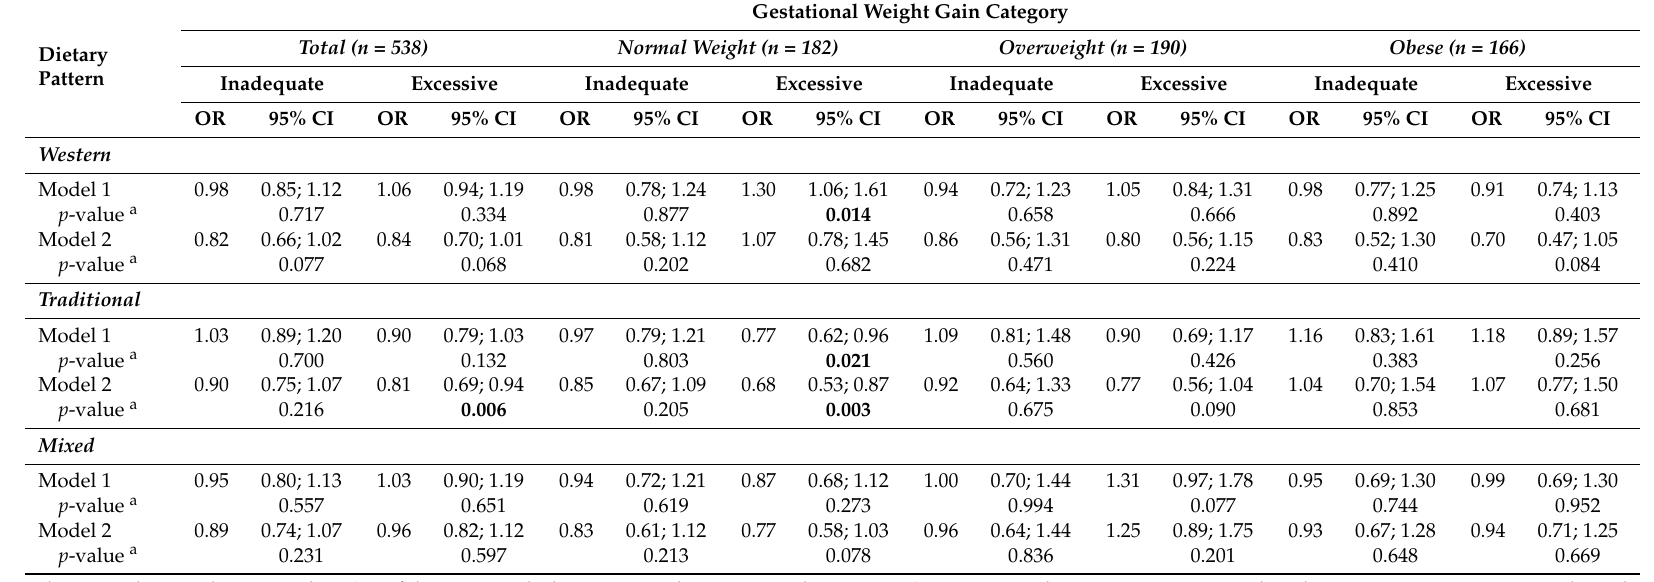
Table 4. Associations between dietary pattern scores and adequacy of gestational weight gain in South African women. Gestational Weight Gain Category Normal Weight (n = 182) Overweight (n = 190) Dietary Pattern Inadequate Excessive Inadequate Excessive Inadequate